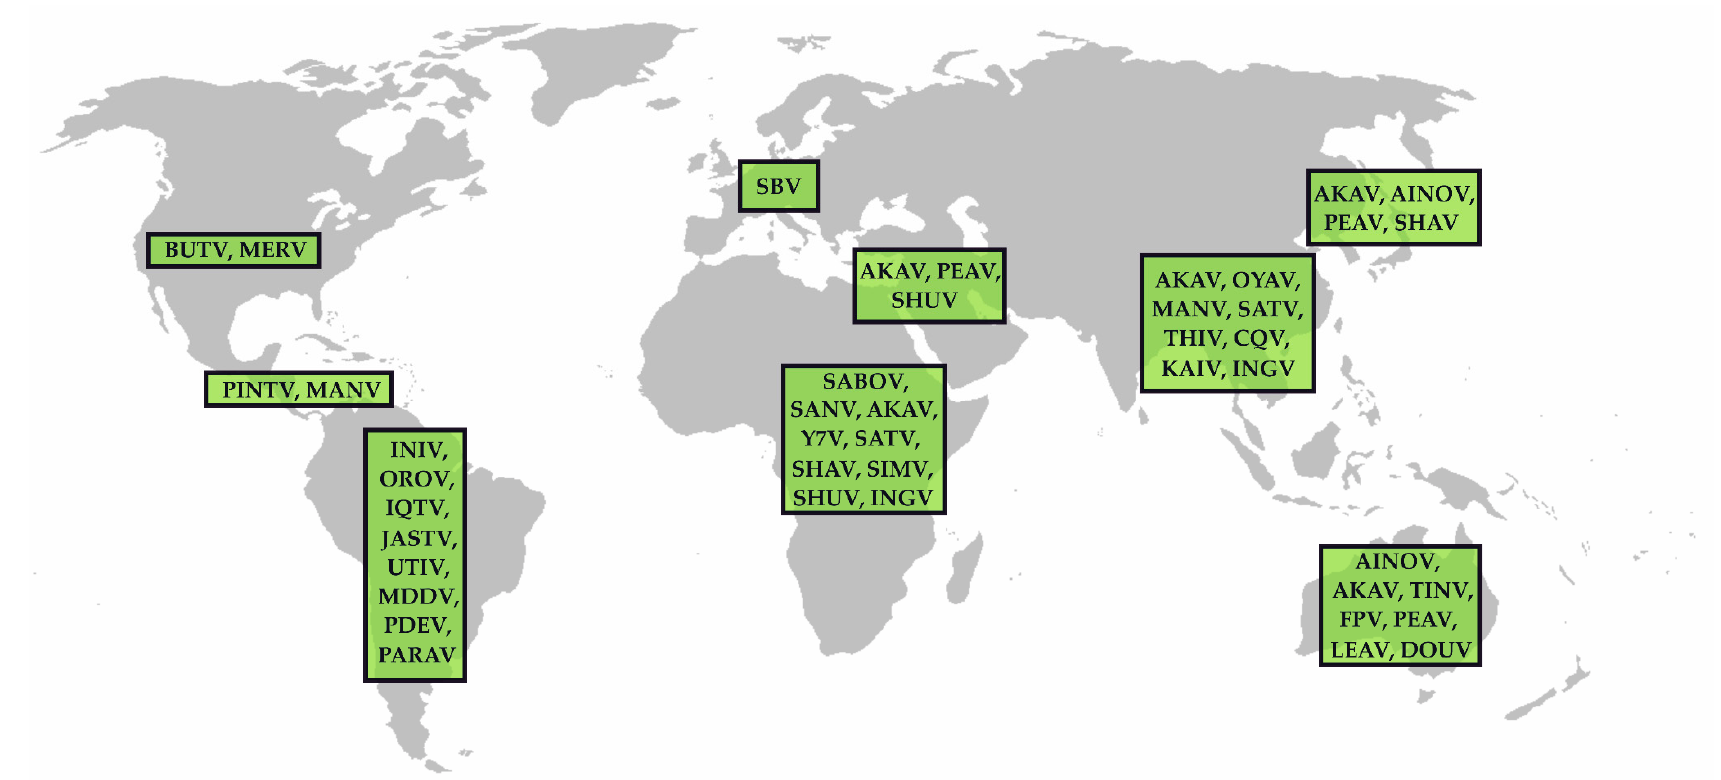
Figure 1. Distribution of Simbu serogroup viruses. The meanings of the abbreviations (virus names) are listed in Table 1.